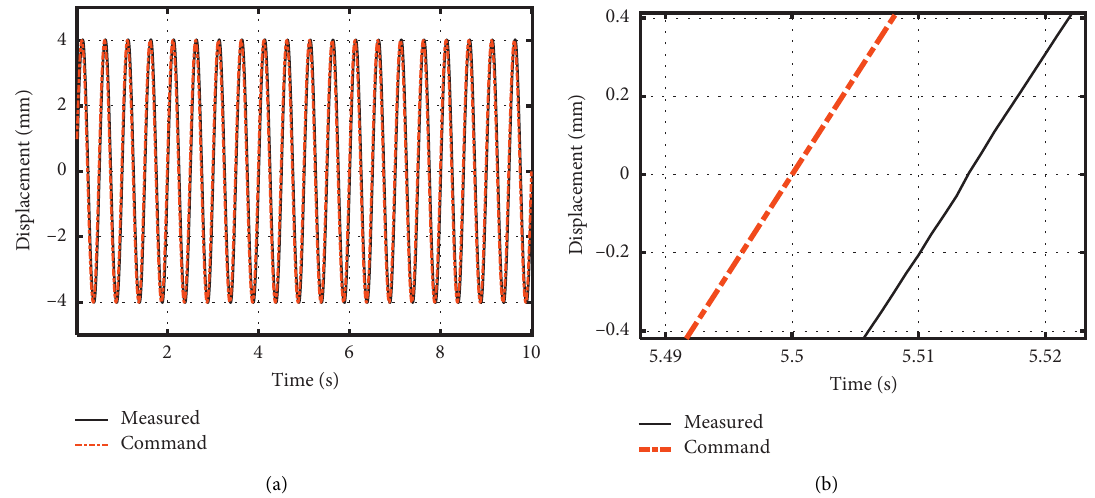
Figure 4: Time histories of command and measured displacements for offline delay estimation. (a) Global view. (b) Close-up view.